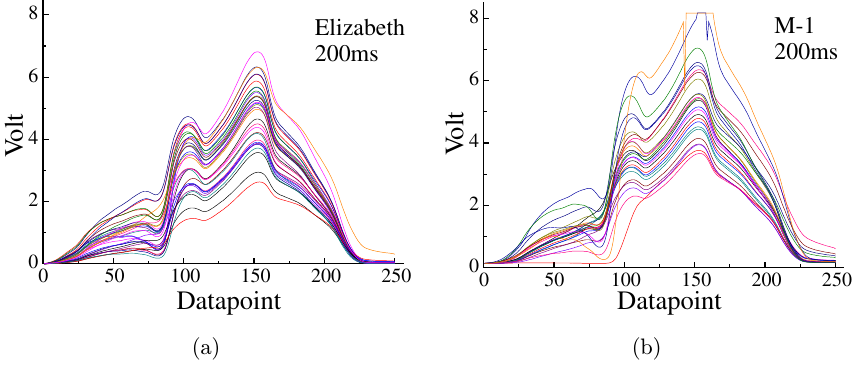
Fig. 3. Energy spectra of (a) Elizabeth and (b) M-1 melon (integration time of 200 ms).